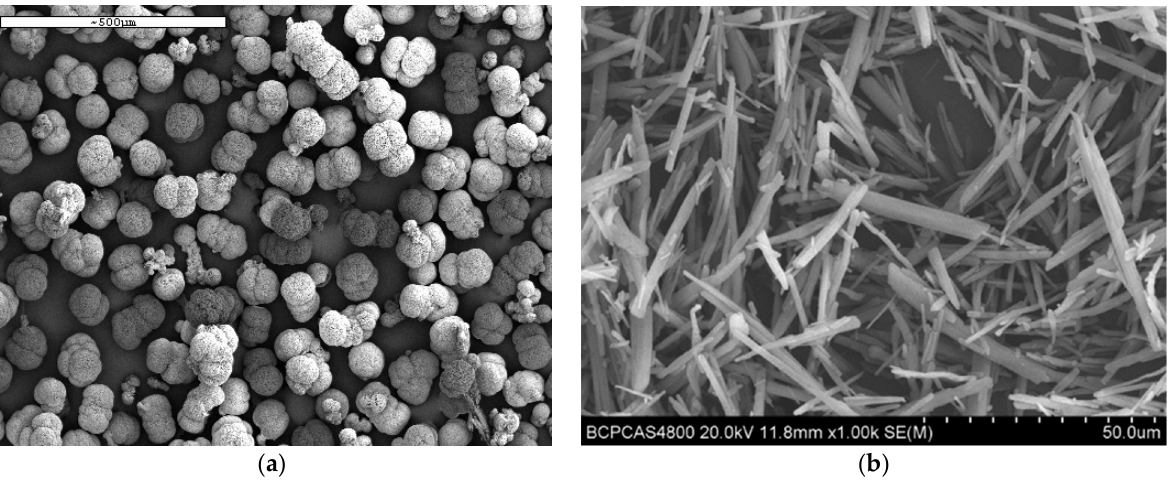
Figure 1. SEM of spherical NQ and ordinary NQ ( a ) spherical NQ; ( b ) ordinary NQ. Instrument: DSC1 differential scanning calorimeter, METTLER TOLEDO, temperature control accuracy is 0.1 K or less; slow baking oven, self-made; temperature controller, temperature control accuracy is 0.2 K; temperature sensor with accuracy of 0.1 K.